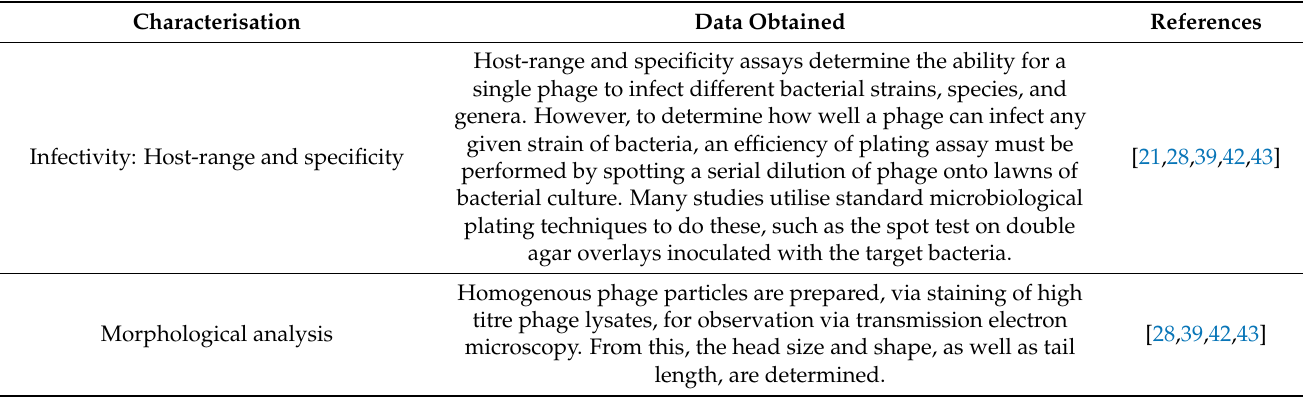
Table 1. List of typical phage characterisations and the data